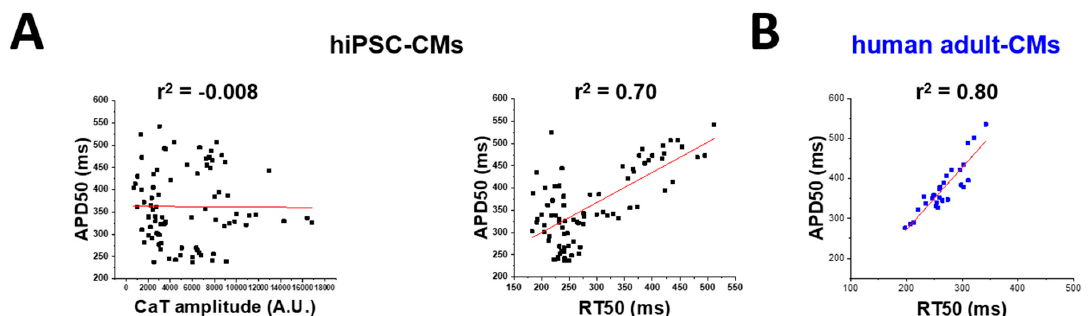
Figure 3. Correlative analysis of action potential and calcium transient parameters. Pearson correlation coe ffi cient ( r 2 ) estimated by linear regression (red line) to correlate APD50 (ms) against CaT amplitude (NS, not significant) and CaT duration (RT50, ms, p < 0.05) of ( A ) day 90 hiPSC-CMs and ( B ) (human) hAdult CMs from donor ventricular tissue ( p <